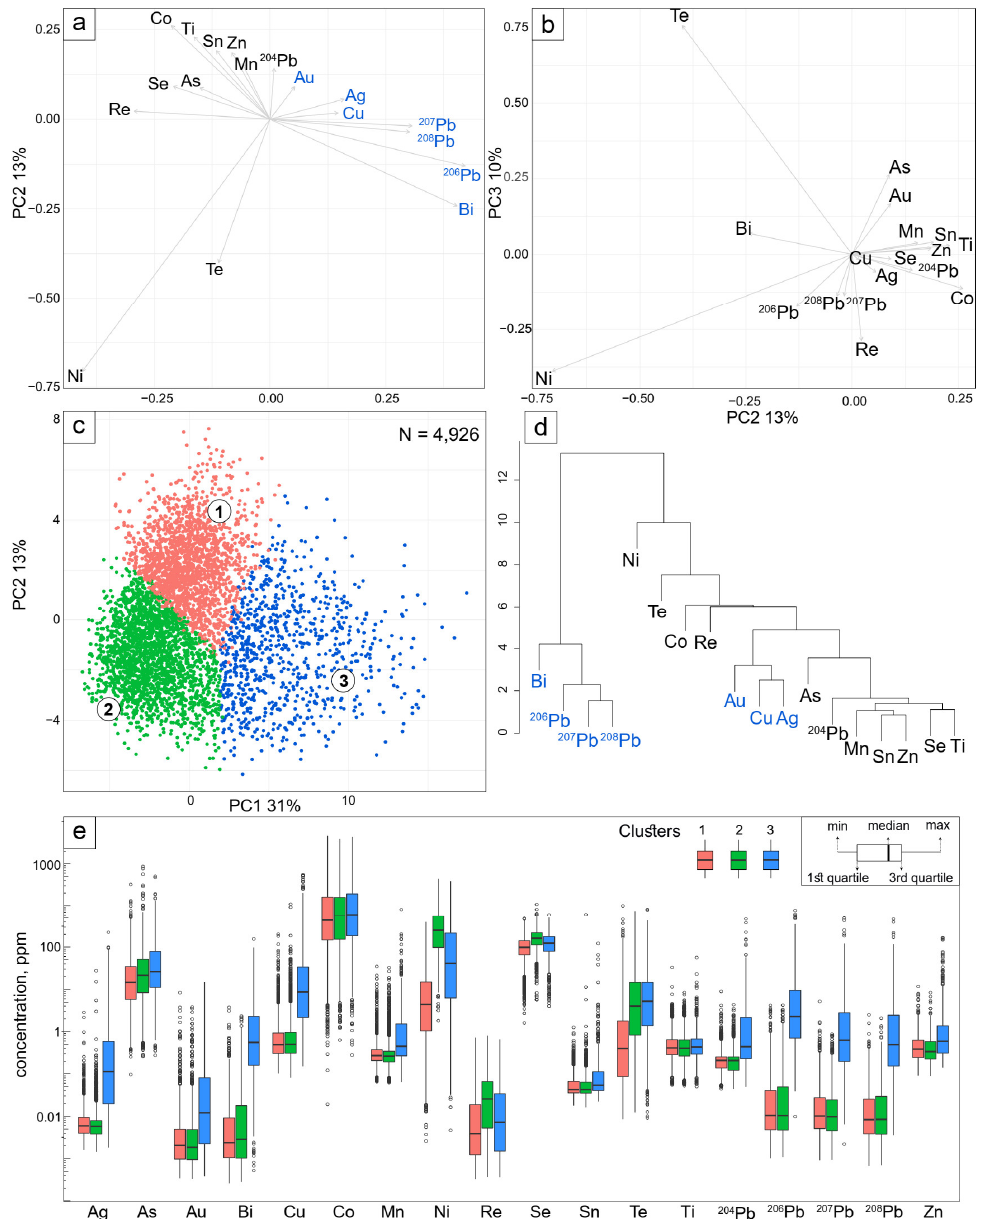
Figure 3. Principal component scores and loadings of centred log-ratio-transformed N = 4926 data. The projection of PC1 versus PC2 ( a ) and PC2 versus PC3 ( b ) shows loadings of the elements. Principal component scores are shown on the PC1 versus PC2 projection ( c ), on which each dot corresponds to an individual sample assigned to one of three clusters. Hierarchical cluster dendrogram ( d ) showing the association among the 18 elements with the height being a dissimilarity measure calculated from the variation matrix using Euclidean metrics (Table 2). ( e ) Box and whisker plot showing a range of concentrations for elements within each cluster. Note the correspondence among Cluster 3 and the Pb isotopes and Bi.